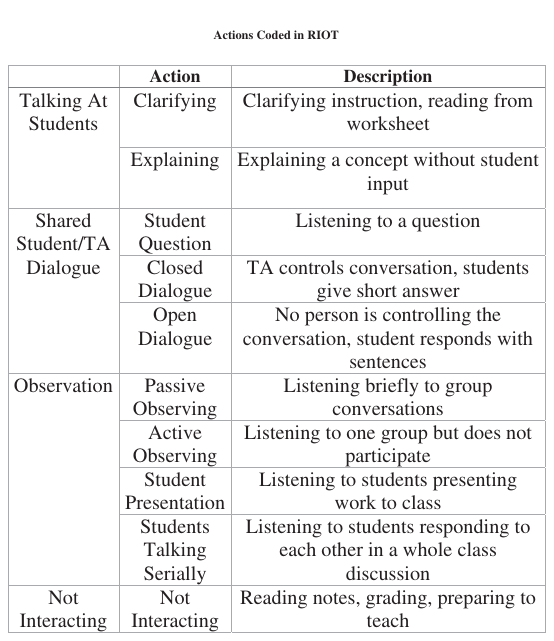
FIG. 8. A copy of the definitions for RIOT codes given to the TAs prior to completing the